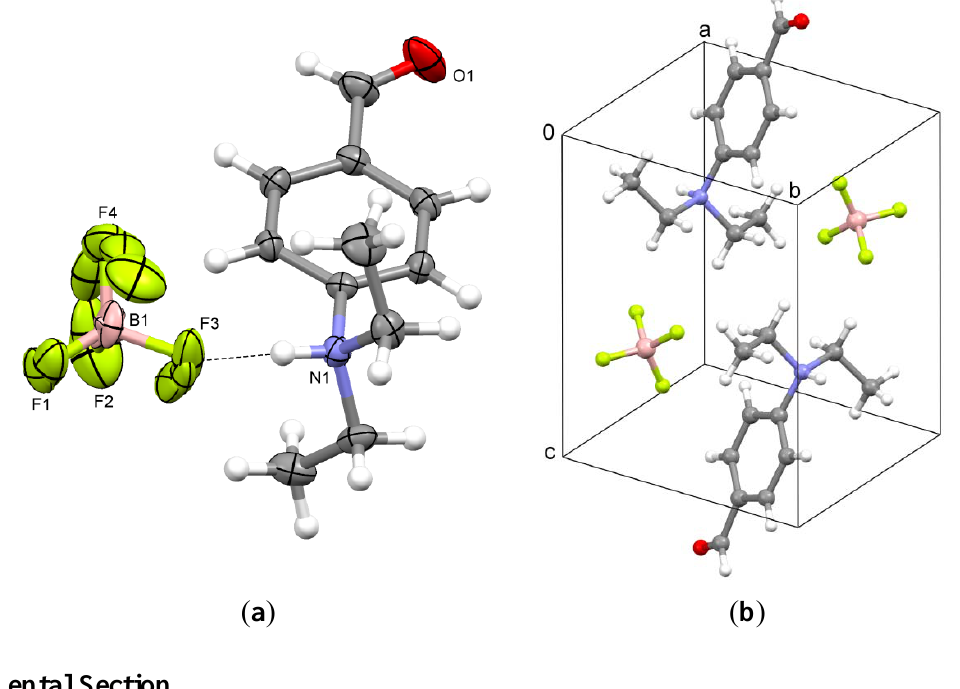
Figure 6. ( a ) Ion pair (ellipsoids at 50 percent probability level); ( b ) Packing of compound 5 in the unit